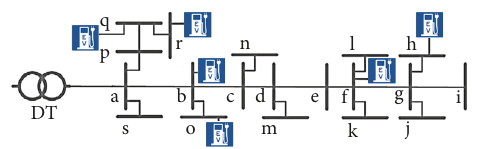
Figure 2: Single-line diagram for 415V